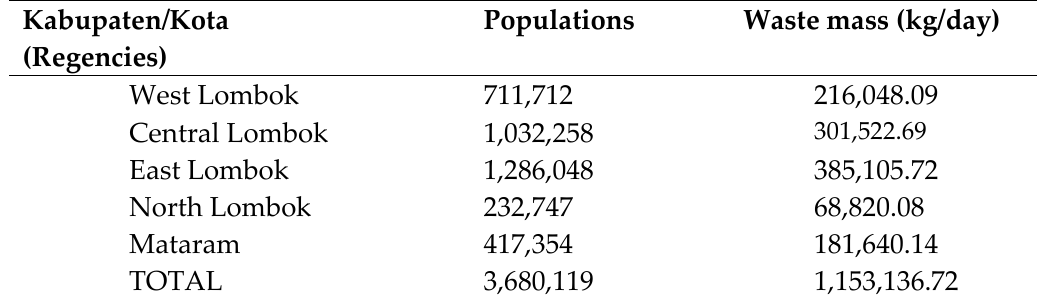
Table 1: The Population Number and Waste Collection in Lombok